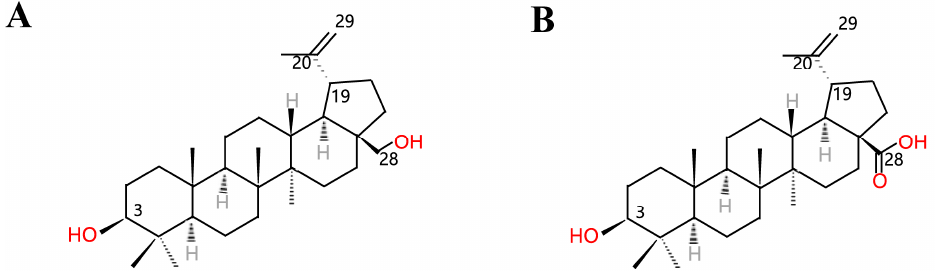
Figure 1. Structures of ( A ) betulin and ( B ) betulinic acid.